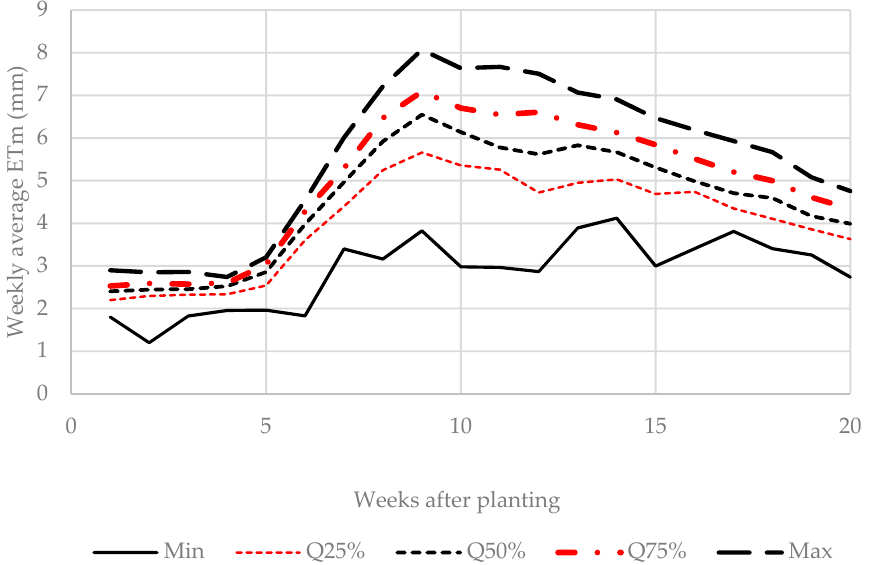
Figure 2. Weekly average daily potential evapotranspiration (ET m ) for quantiles 25% (Q25%), 50% (Q50%), 75% (Q75%), minimum (Min), and maximum (Max).